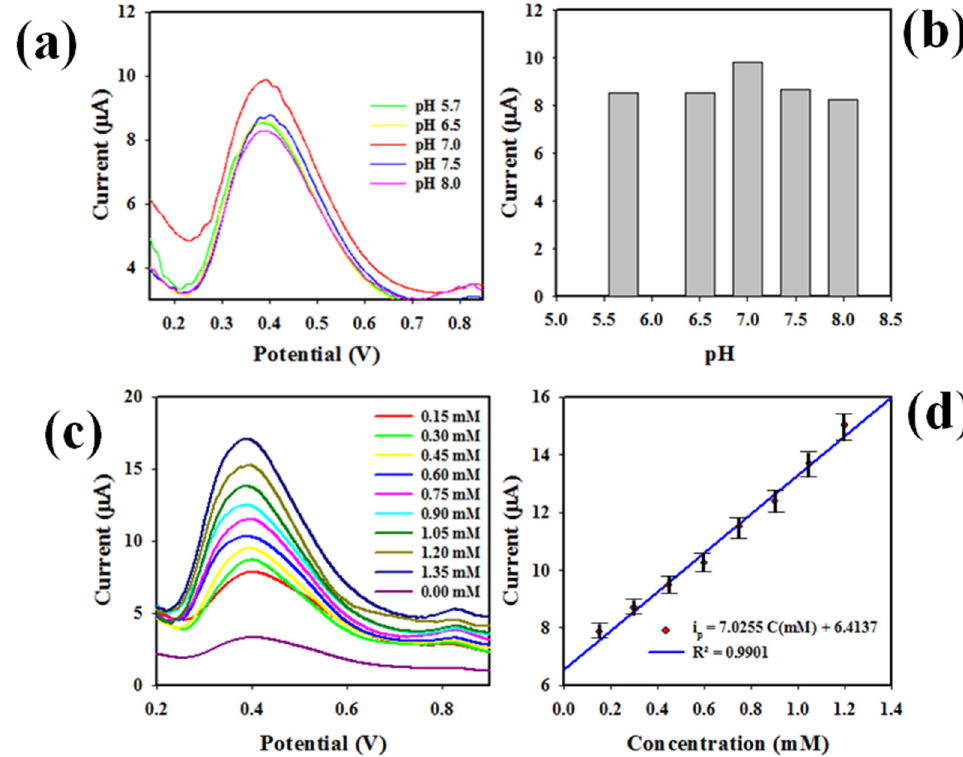
Figure 8. Detection of target chemicals with PbO-doped NiO NCs. ( a ) pH optimization DPV analysis